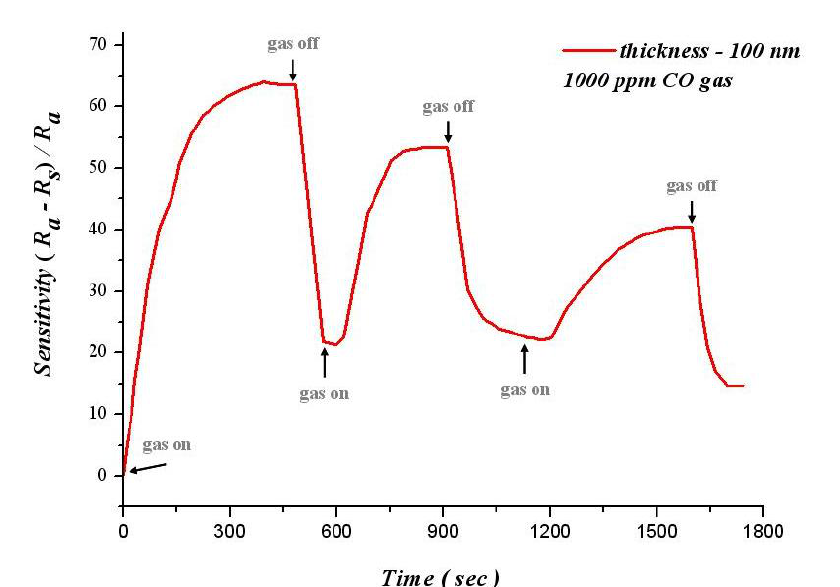
Figure 11. Analysis of reproducibility and stability (T = 300 °C).